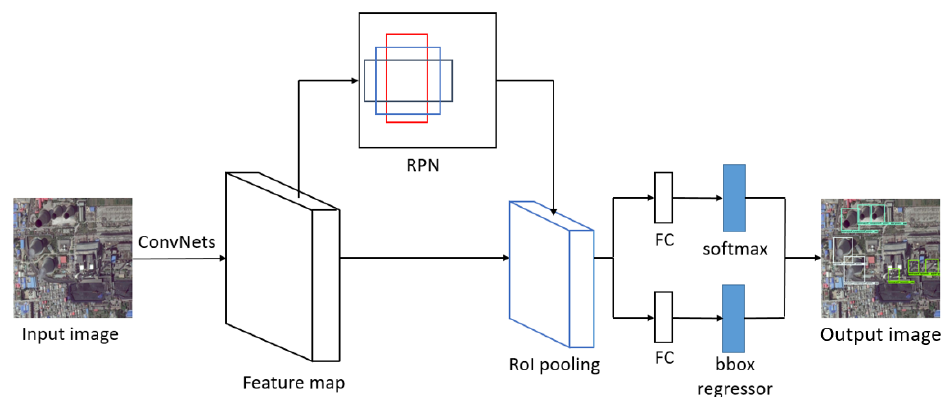
Figure 1. The framework of Faster R-CNN. RPN, region proposal network; RoI, region of interest; FC, fully connected layer; bbox, bounding box.